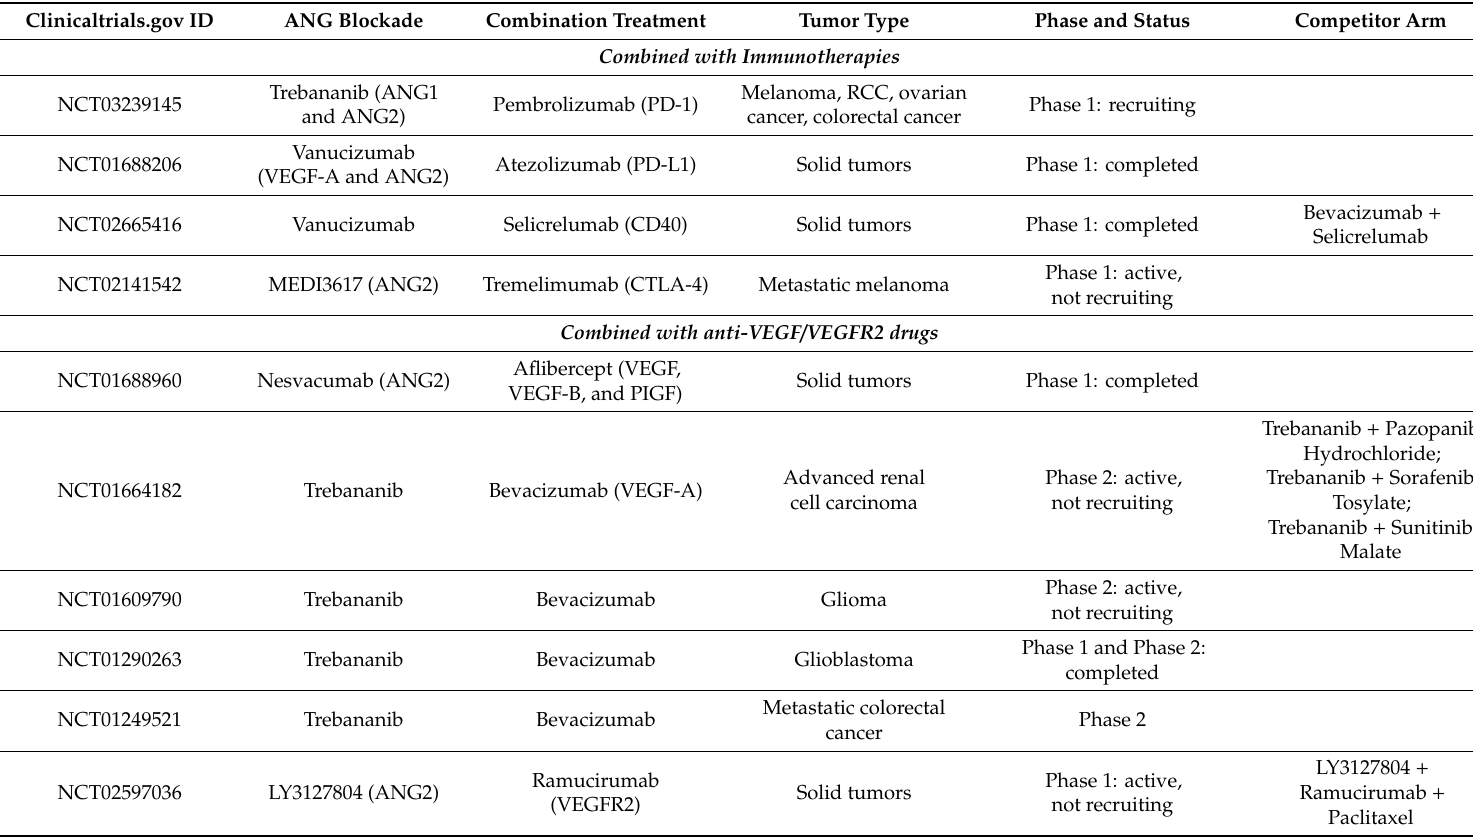
Table 1. Clinical studies testing ANG-targeted therapies in combination with antiangiogenic and immunotherapies in cancer treatment. Clinicaltrials.gov